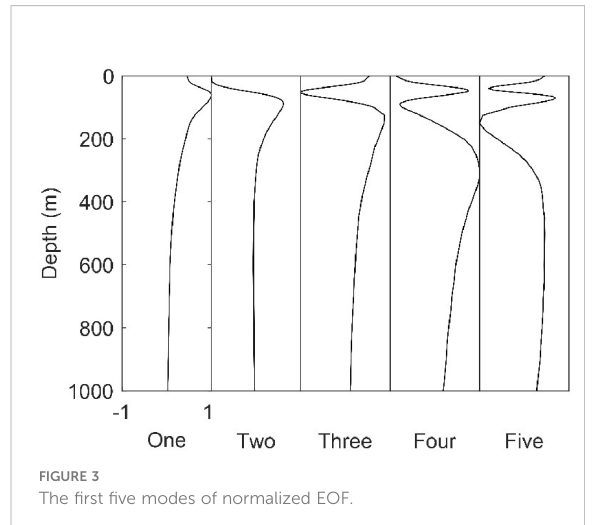
FIGURE 3 The fi rst fi ve modes of normalized